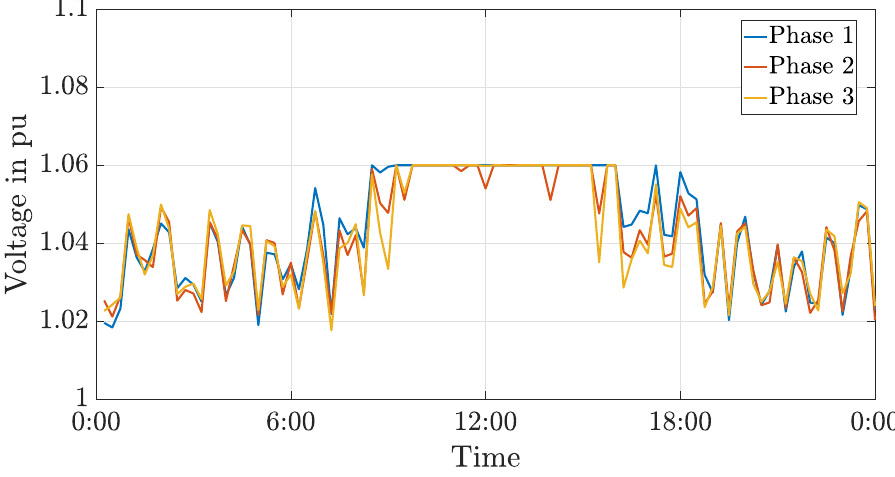
Figure 13. Voltages at the end of the feeder.